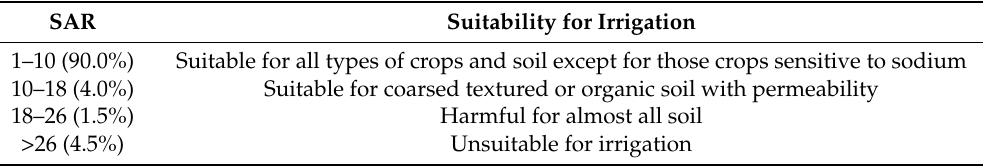
Table 7. Suitability of water for irrigation with different value of